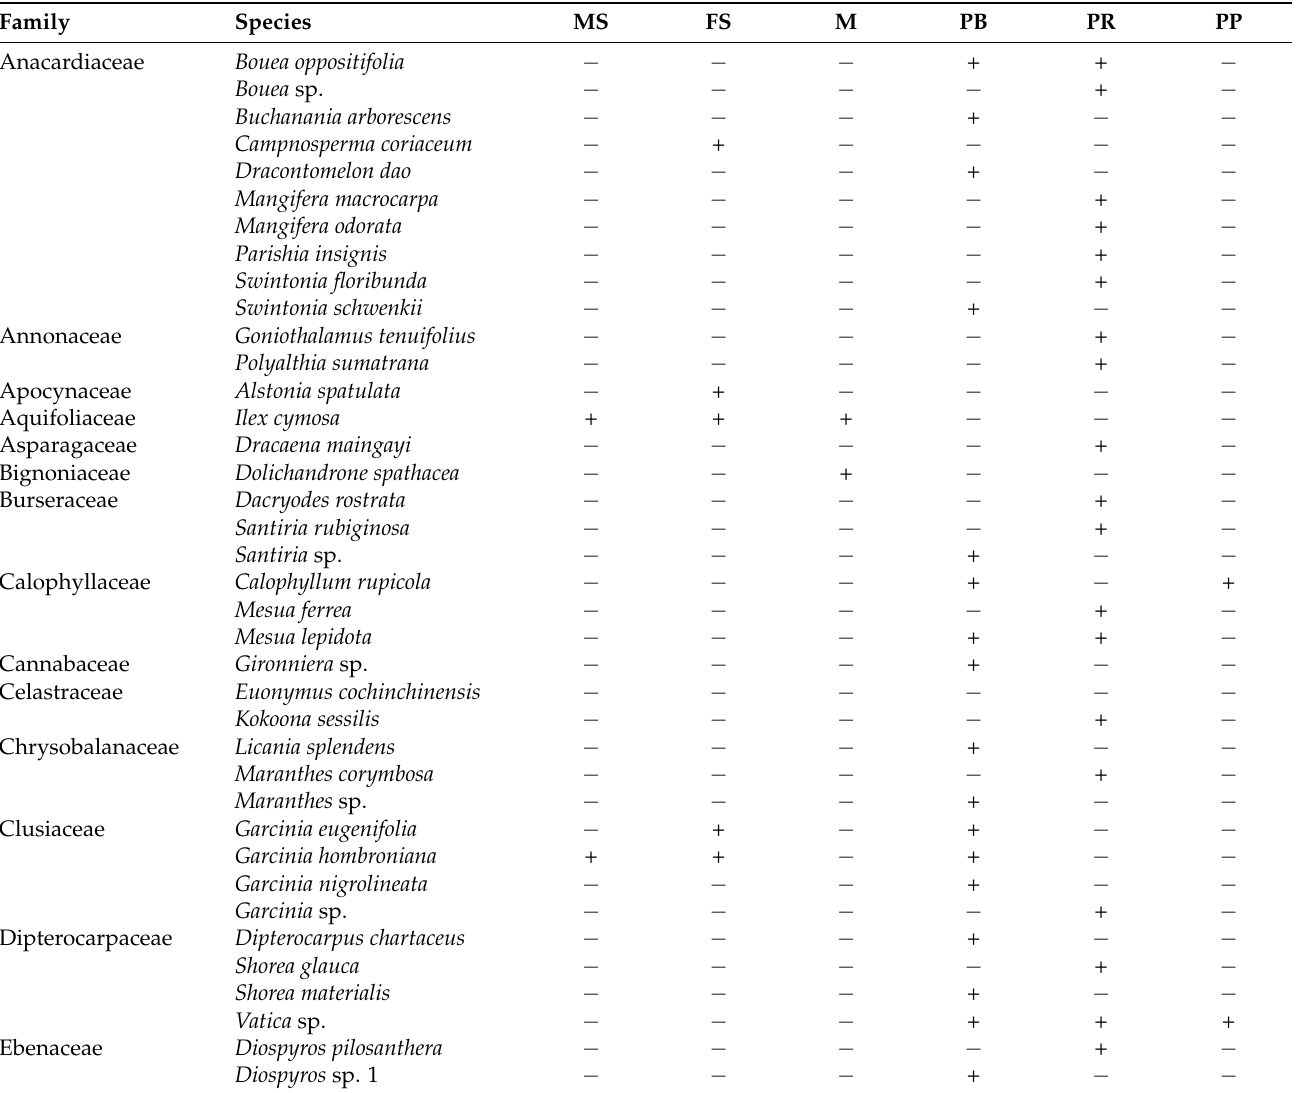
Table 2. Species list based on plot-based tree inventories. MS = Melaleuca swamp, FS = freshwater